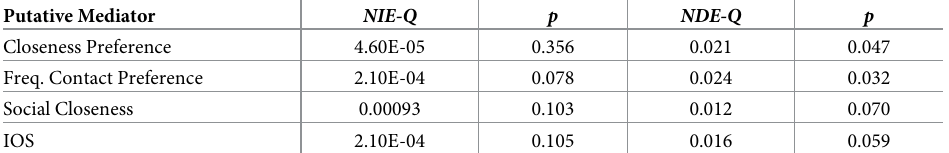
Table 5. Omnibus test for mediation of the association between loneliness and interpersonal distance preference within intimate space. Putative Mediator